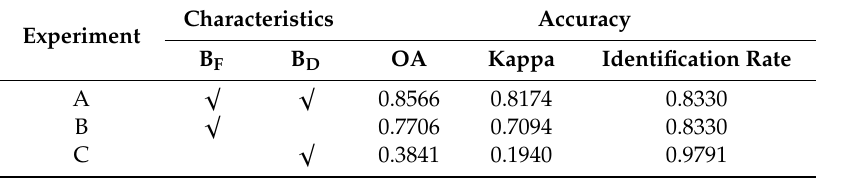
Table 4. The accuracy rate of identifying buildings with different spatial scales using the traditional method.